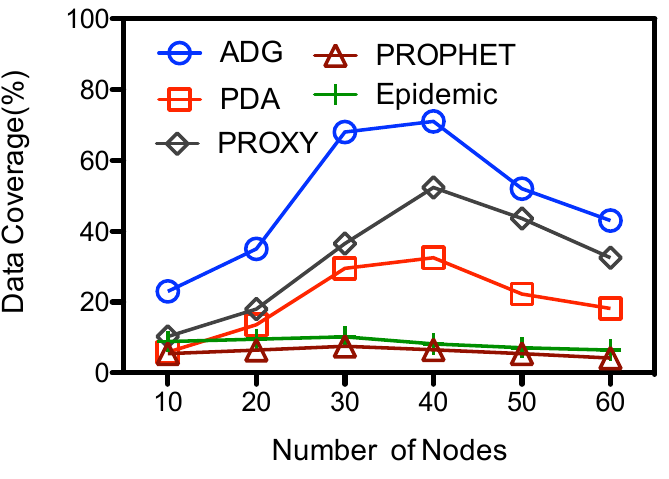
Figure 7. Number of nodes vs. data coverage.